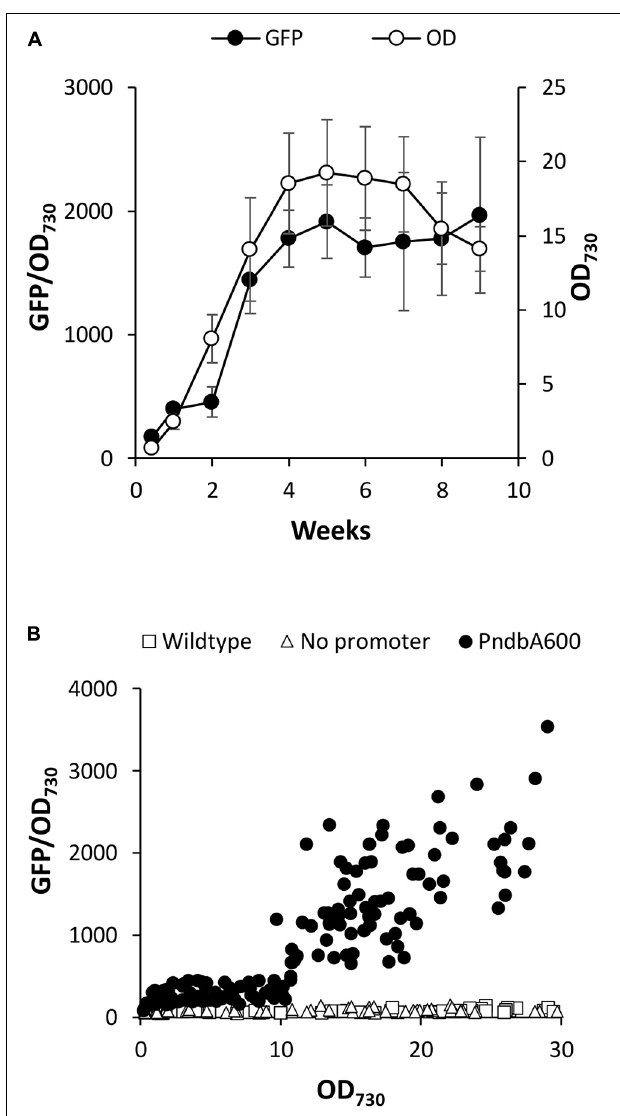
FIGURE 4 | Heterologous PndbA600 activity under control conditions. (A) Promoter activity (black circles, GFP fluorescence normalised to OD 730 , left axis) in Synechococcus PndbA600:GFP. Culture density (OD 730 , right axis) is shown with white circles. Data are means ± S.E.M. of three independent cultures grown in control A + media. (B) Promoter activity (GFP fluorescence normalised to OD 730 ) against culture density (OD 730 ) of Synechococcus cultures grown in control conditions. Data are shown for the following lines: wild-type (no GFP, squares, n = 7), no promoter ( Synechococcus transformed with GFP, triangles, n = 6), Synechococcus expressing GFP under the control of PndbA600 ( Synechococcus PndbA600:GFP, circles). Measurements taken after maximum culture density was achieved are not